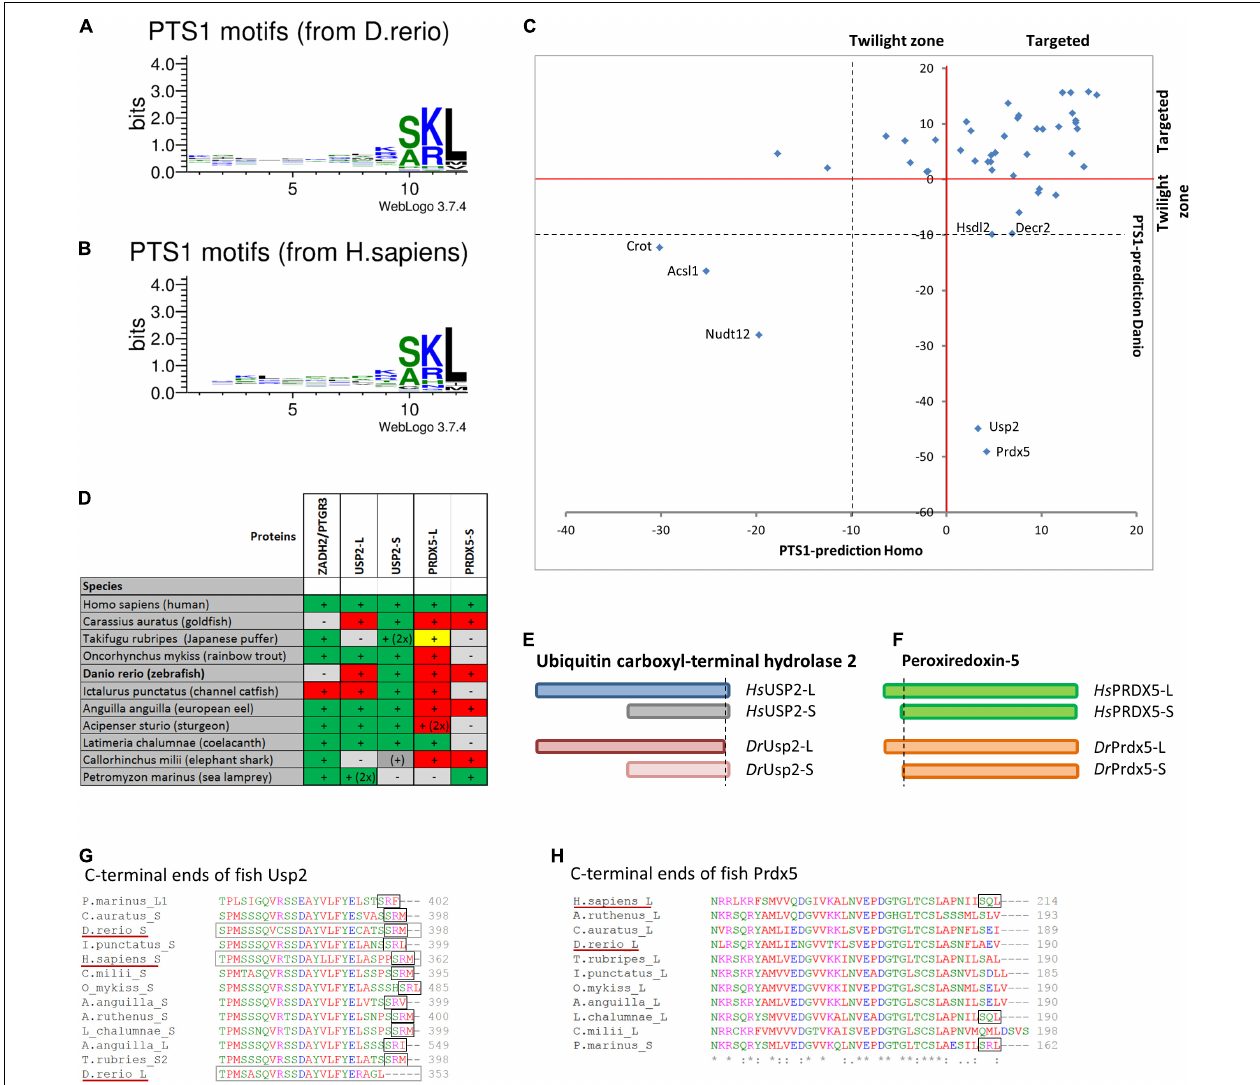
FIGURE 4 | Comparison of PTS1 motifs between D. rerio and H. sapiens : To depict the difference in the average abundance of amino acids at different positions of the PTS1 in fish (A) and humans (B) , we selected proteins from each species, which were predicted to harbour a PTS1 (Neuberger et al., 2003), and depicted them as WebLogo (http://weblogo.threeplusone.com/create.cgi). (C) A comparison of the numerical values of the PTS1-predictions for those proteins is plotted for H. sapiens ( x -axis) and D. rerio ( y -axis) and depicted relative to the threshold for the evaluation of targeted proteins ( > 0, red) or the “twilight zone” (–10 < x < 0, grey); proteins with negative prediction are highlighted. (D) Systematic overview of orthologous fish proteins, which were either not found in D. rerio (ZADH2/PTGR3) or lack a PTS1 (Usp-L, long isoform; Prdx-5). (+) or (–) indicate presence or absence of the protein; 2x indicates 2 variants; traditional PTS1 identified (green) or not found (red); non-canonical PTS1 (yellow). (E) Schematic representation of the two isoforms of ubiquitin carboxyl-terminal hydrolase 2 (USP2) in H. sapiens (blue) and D. rerio (red). No PTS1 was found in the long isoform of Usp2 (Usp2-L). (F) Schematic representation of the two isoforms of peroxiredoxin-5 (Prdx-5) in H. sapiens (green) and D. rerio (orange). The long variant harbours an additional mitochondrial targeting signal, whereas the C-terminal sequence is identical. (G,H) Sequence comparison of the C-terminal end of USP2 orthologues (G) and PRDX5-orthologues (H) . The loss of the PTS1 in Usp2-L is unique for D. rerio , whereas the PTS1 of human PRDX5 is found only in more ancient fish